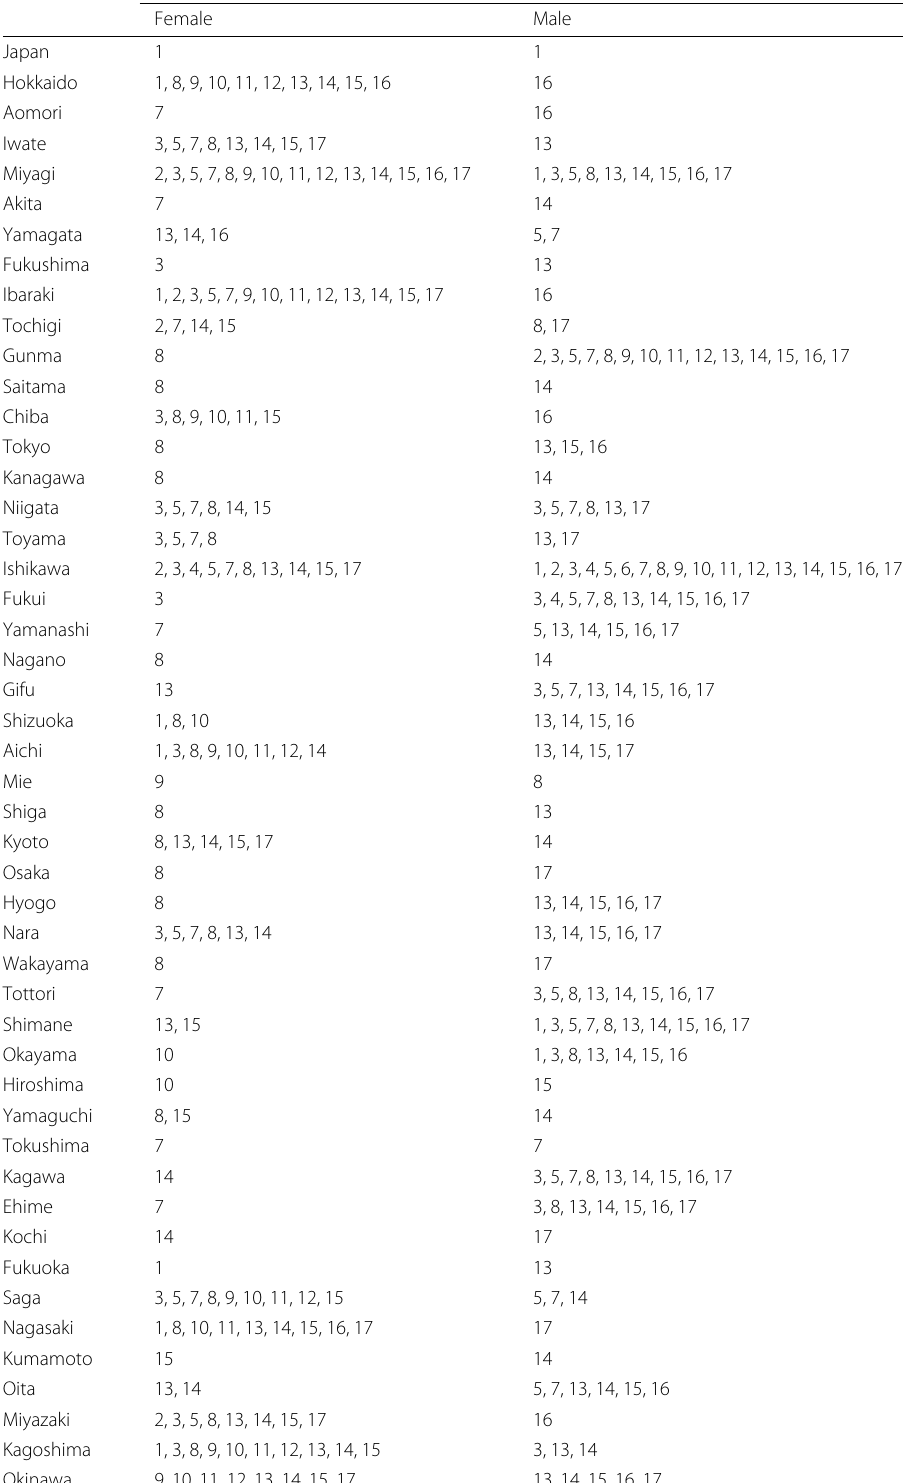
Table 2 MCS procedure using the T max,M test applied to the RMSFE in the validation set from 1996 to 2005 for forecasting the Japanese female and male national and sub-national mortality for ages between 60 and 100+. From the 17 models, below is the selected superior set of the model(s) Population Superior